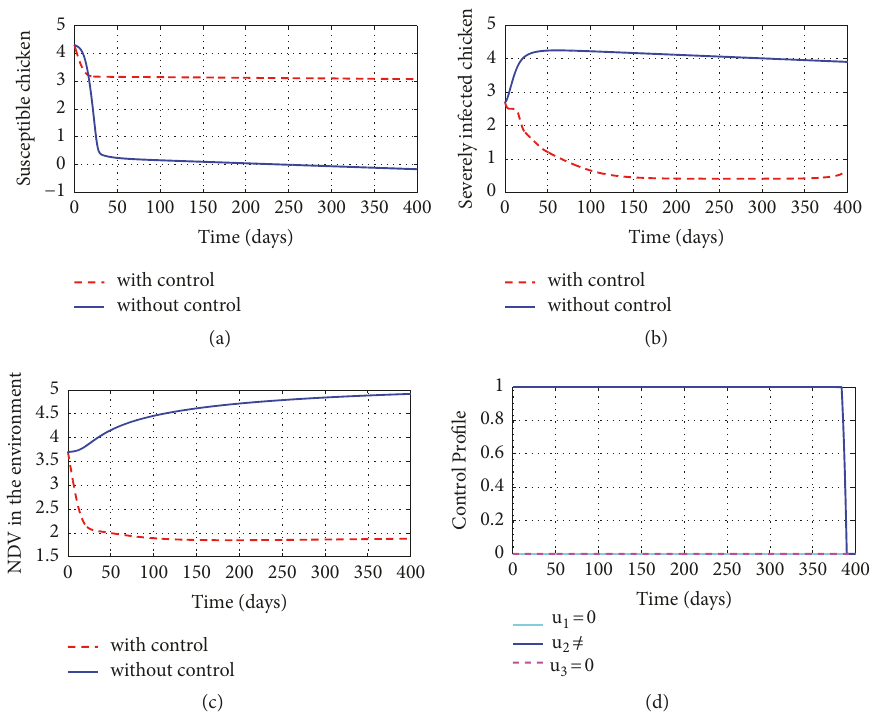
Figure 3: Optimal solutions for model variables 𝑆 𝑐 , 𝐼 𝑐 , 𝐻 and the control profiles for 𝑢 1 , 𝑢 2 , 𝑢 3 with ( 𝑢 1 = 0 , 𝑢 2 ̸= 0 , 𝑢 3 = 0